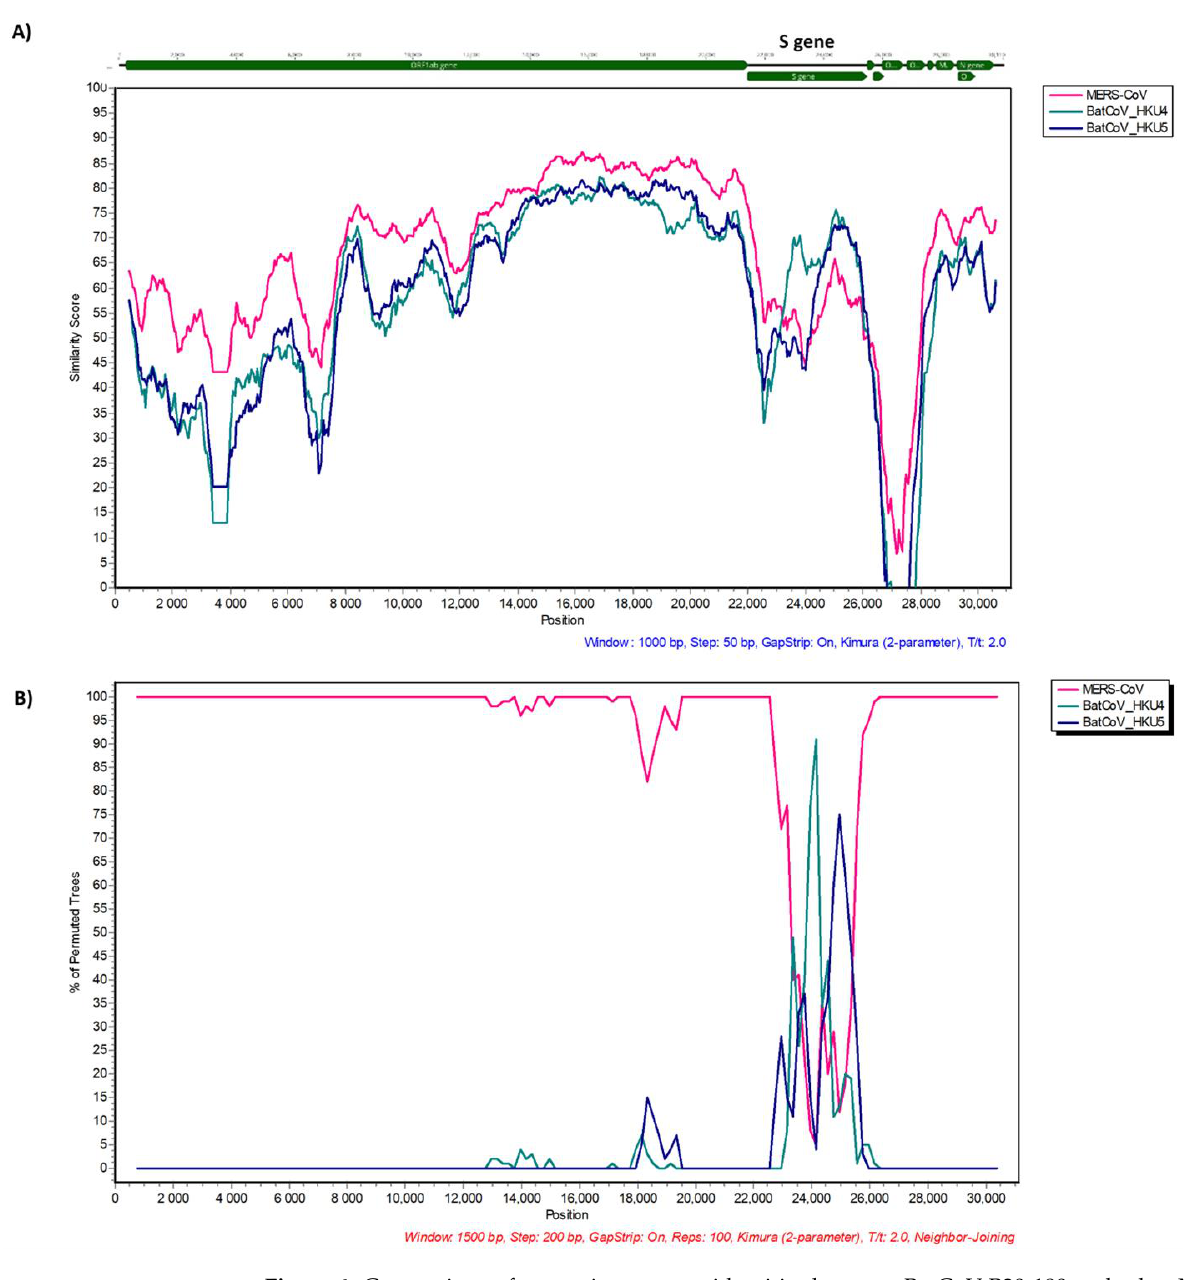
Figure 6. Comparison of genomic sequence identities between BatCoV B20-180 and other Merbecoviruses ( A ) and evidence for recombination events ( B ). The SimPlot and BootScan plots were generated using Simplot (v3.5.1).